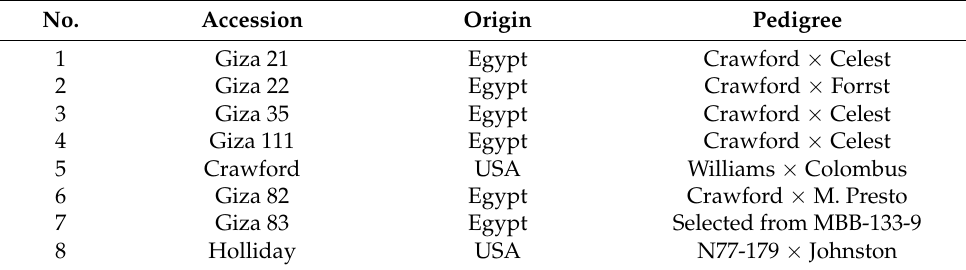
Table 8. Origin and pedigree for the used eight soybean cultivars.